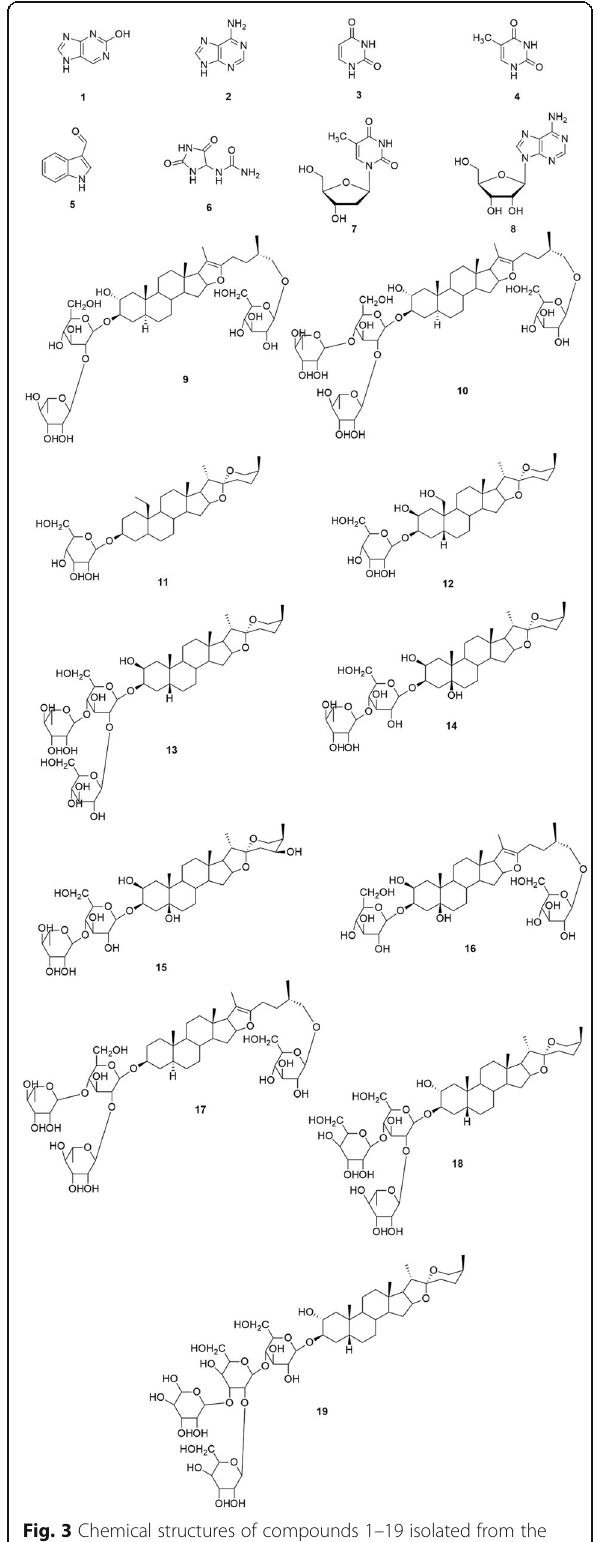
Fig. 3 Chemical structures of compounds 1 – 19 isolated from the seed of A. tuberosum